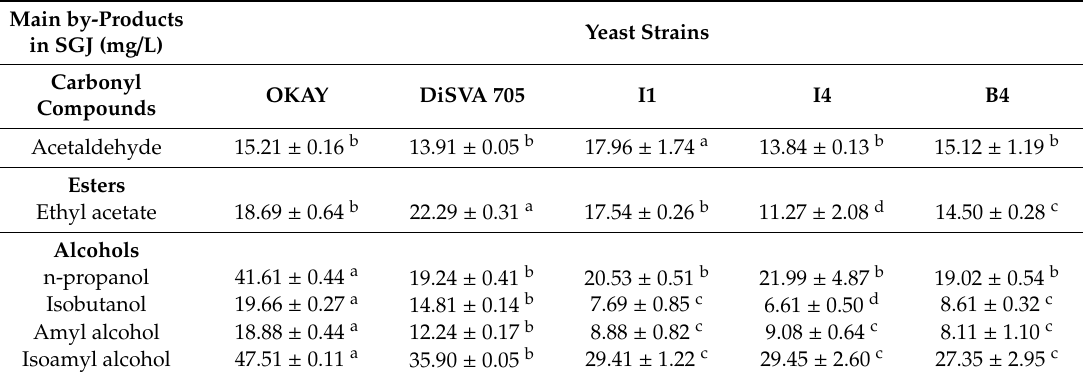
Table 3. Main fermentation byproducts in SGJ.